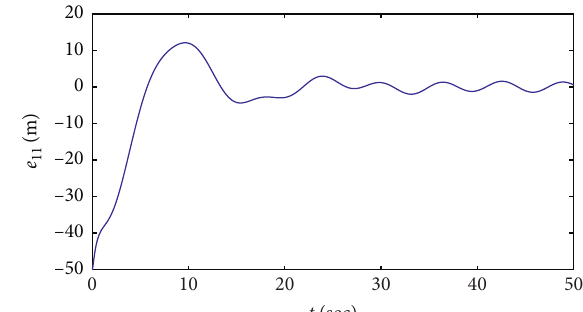
Figure 4: The tracking control error of the helicopter displacement x .